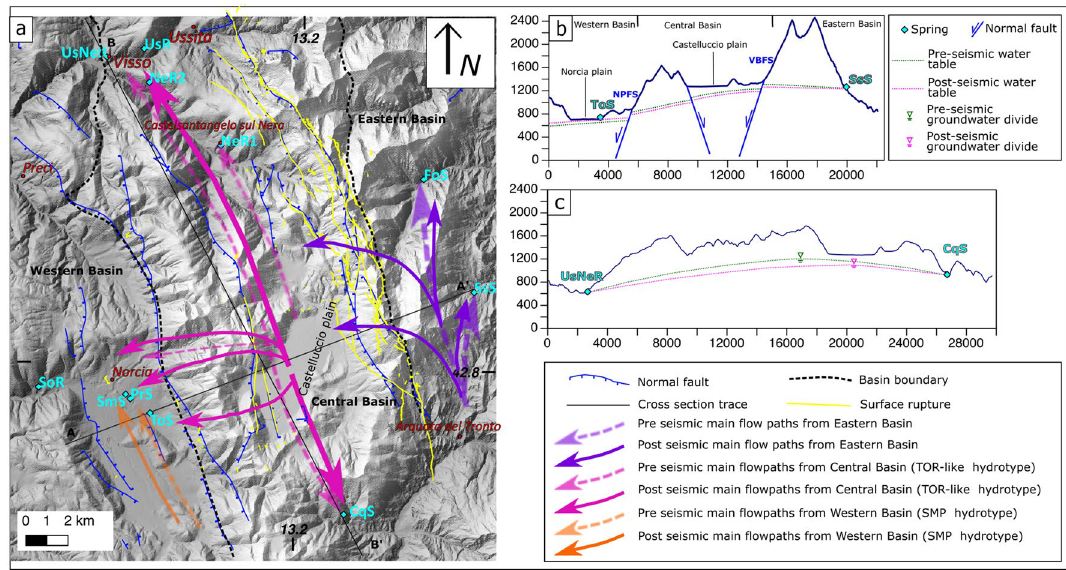
Figure 5. Conceptual scheme of hydrogeological modifications induced by the seismic sequence. The base map was obtained by elaborating the digital elevation model (DEM) from the TINITALY/01 DEM of the whole Italian territory (https:// tinit aly. pi. ingv. it/; Tarquini et al. 41 ; CC BY 4.0 License, http:// creat iveco mmons. org/ licen ses/ by/4. 0/), by means of the Open Source package QGis v 3.16 (https:// www. qgis. org/ en/ site/). The map has been then edited with the Open Source software Inkscape v.1.2.1 (https:// inksc ape. org/ about/ licen se/). Surface ruptures data are from 42–44 after: (1) Brozzetti et al. (ref 42 Open access, Creative Commons Attribution 4.0 International License, https:// doi. org/ 10. 1029/ 2018t c0053 05); (2) Pucci et al. (ref 43 , free access available at https:// doi. org/ 10. 1002/ 2016G L0718 59; (3) Villani et al. (ref 44 free access available at: https:// doi. org/ 10. 1029/ 2018T C0051 75). ( a ) Pre-seismic (dashed lines) and post-seismic (continuous lines) main flow-paths. Variations in line width represent increase or decrease of groundwater flow with respect to pre-seismic conditions. Different flow lines colours indicate different hydro-chemical characteristics. ( b ) Pre-seismic elevation of saturated zone in the three Basins. ( c ) Post-seismic modification of saturated zone elevation in Central Basin with potential migration of groundwater